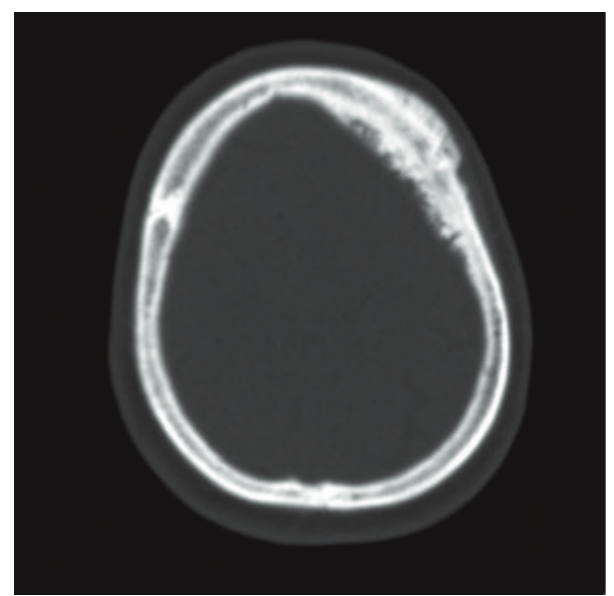
Fig. 2. Axial T1-weighted MR image demonstrates a focal expansile hypo- intense bone lesion in the superior left fronto-parietal region of the skull. There are no radiologically evident intracranial abnormalities.